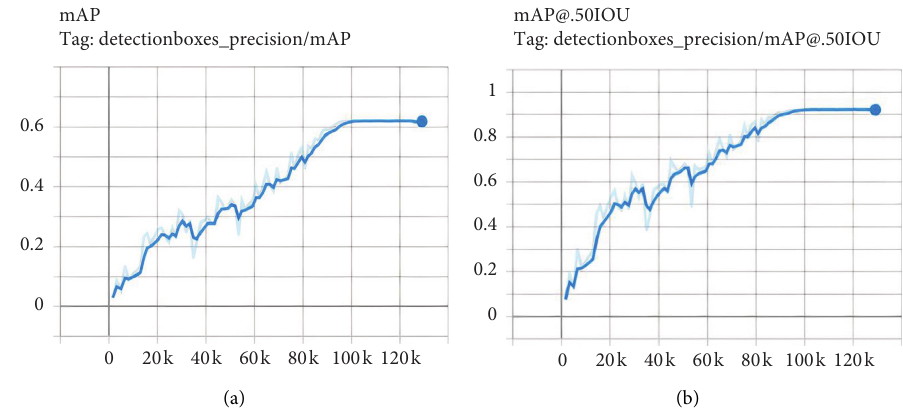
Figure 10: Accuracy of SSD MobileDet model during training. (a) mAP@0.5:0.95; (b) mAP@0.5.